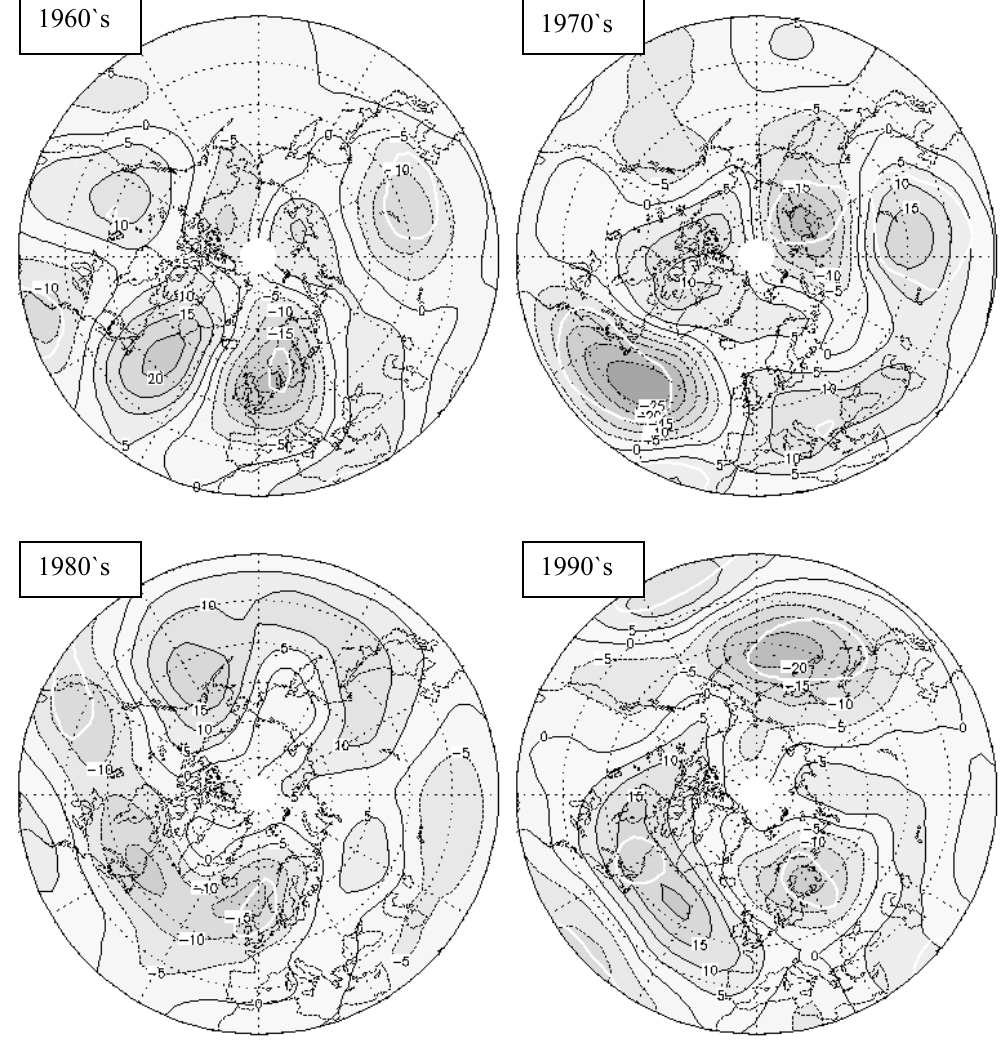
Figure 3: Same as Figure 1, but for February. Fig. 3. Same as Fig. 1, but for